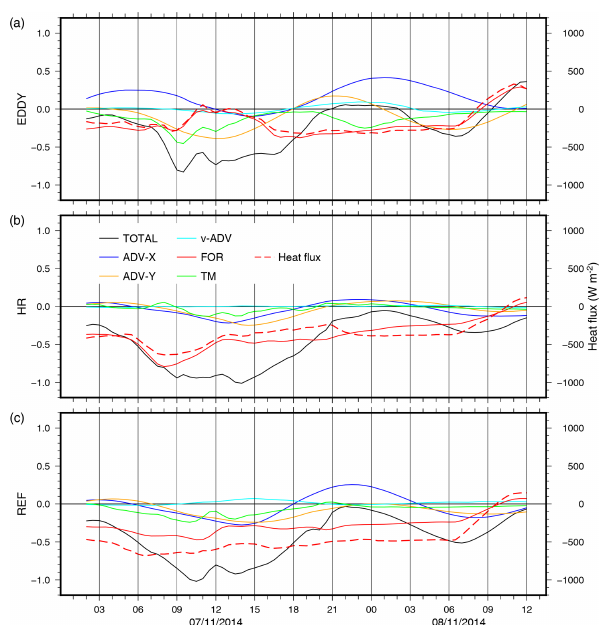
Figure 12. Time series of the different components of the tendency in the evolution of temperature in the OML, in the EDDY (a) , HR (b) , and REF (c) areas. The net downward heat flux is also shown (dashed red line, right-hand-side scale).